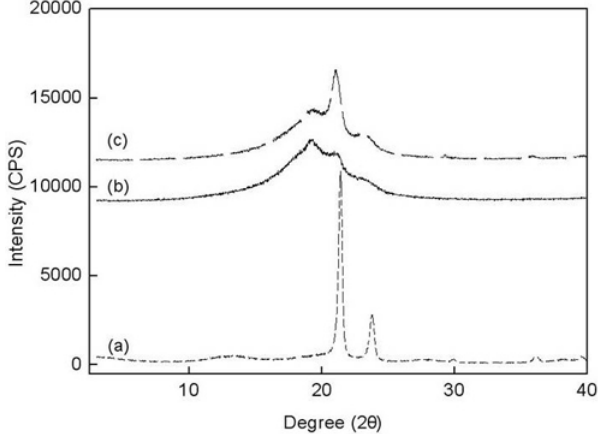
) curves according to the p